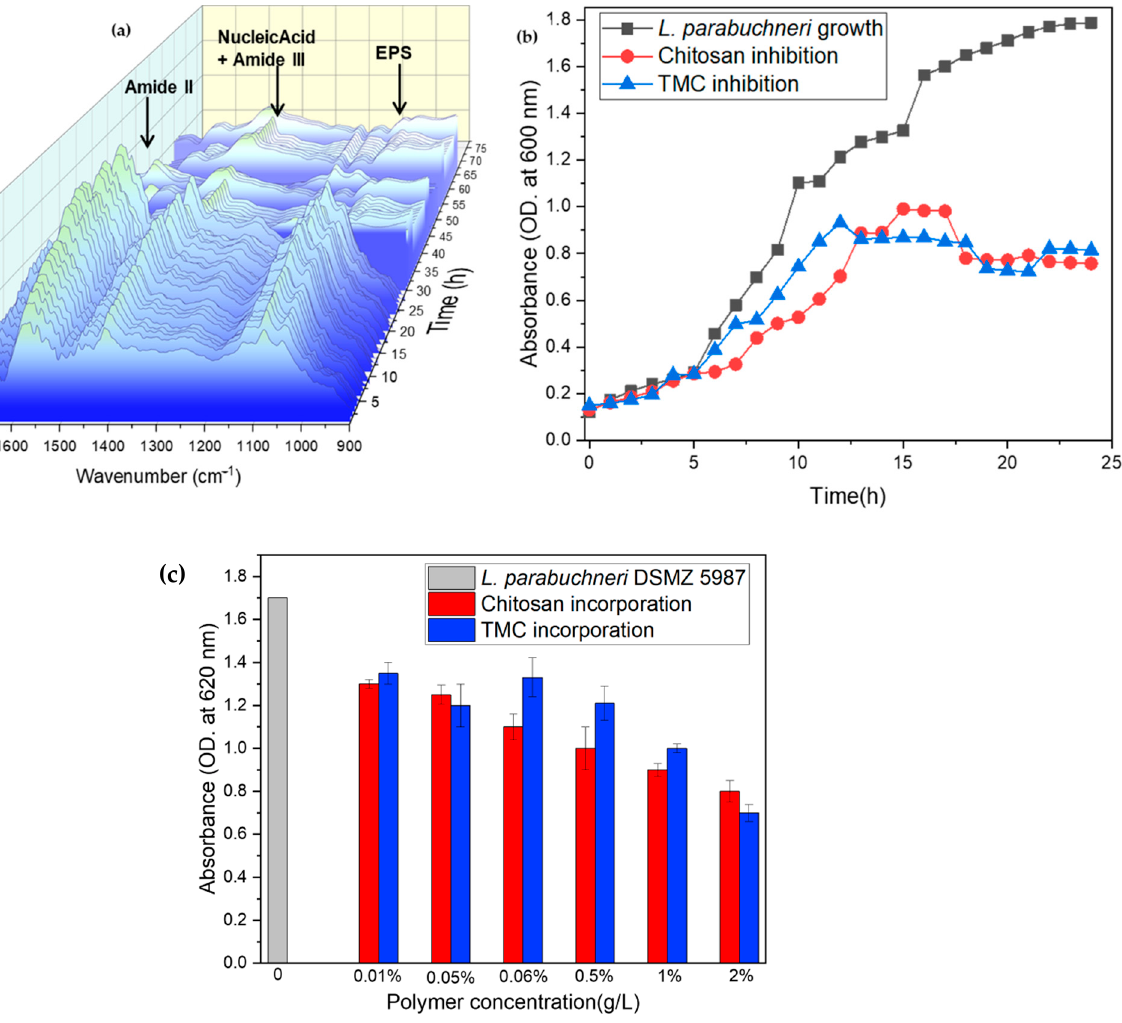
Figure 3. ( a ) Three-dimensional plot of IR-ATR spectra during three days of monitoring of temporal biofilm inhibition, ( b ) growth profile of L. parabuchneri DSMZ 5987 as assayed by turbidimetry at 620 nm compared to chitosan and TMC in 2 g/L concentration added to the MRS medium during a 24 h interaction with bacteria, and ( c ) inhibition histogram of chitosan and TMC derivative as a function of different polymer concentrations added to MRS media for 16 h of antimicrobial-biofilm interactions. The error bars represent the standard deviation of three independent experiments.